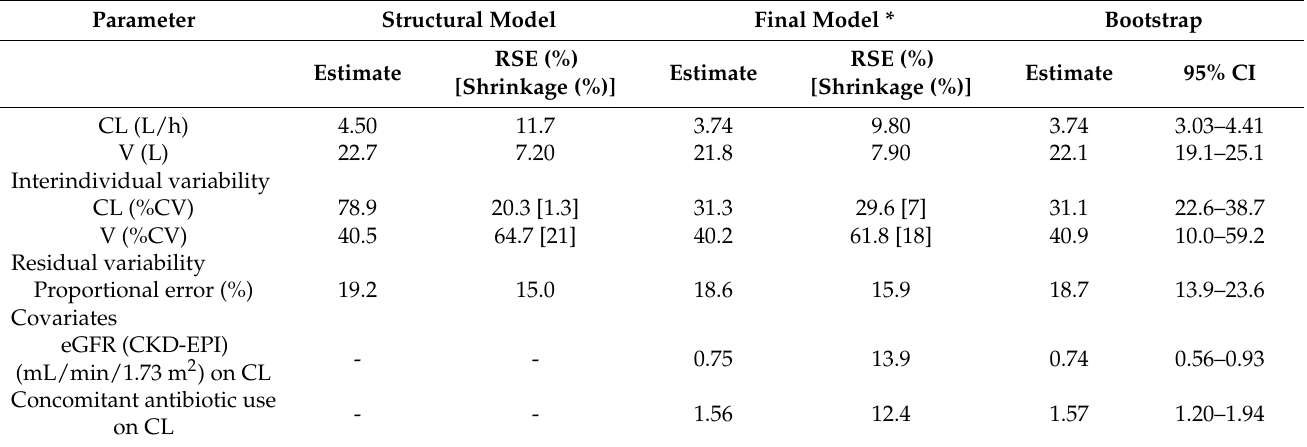
Table 3. Parameter estimates of the structural, final model and bootstrap analysis.